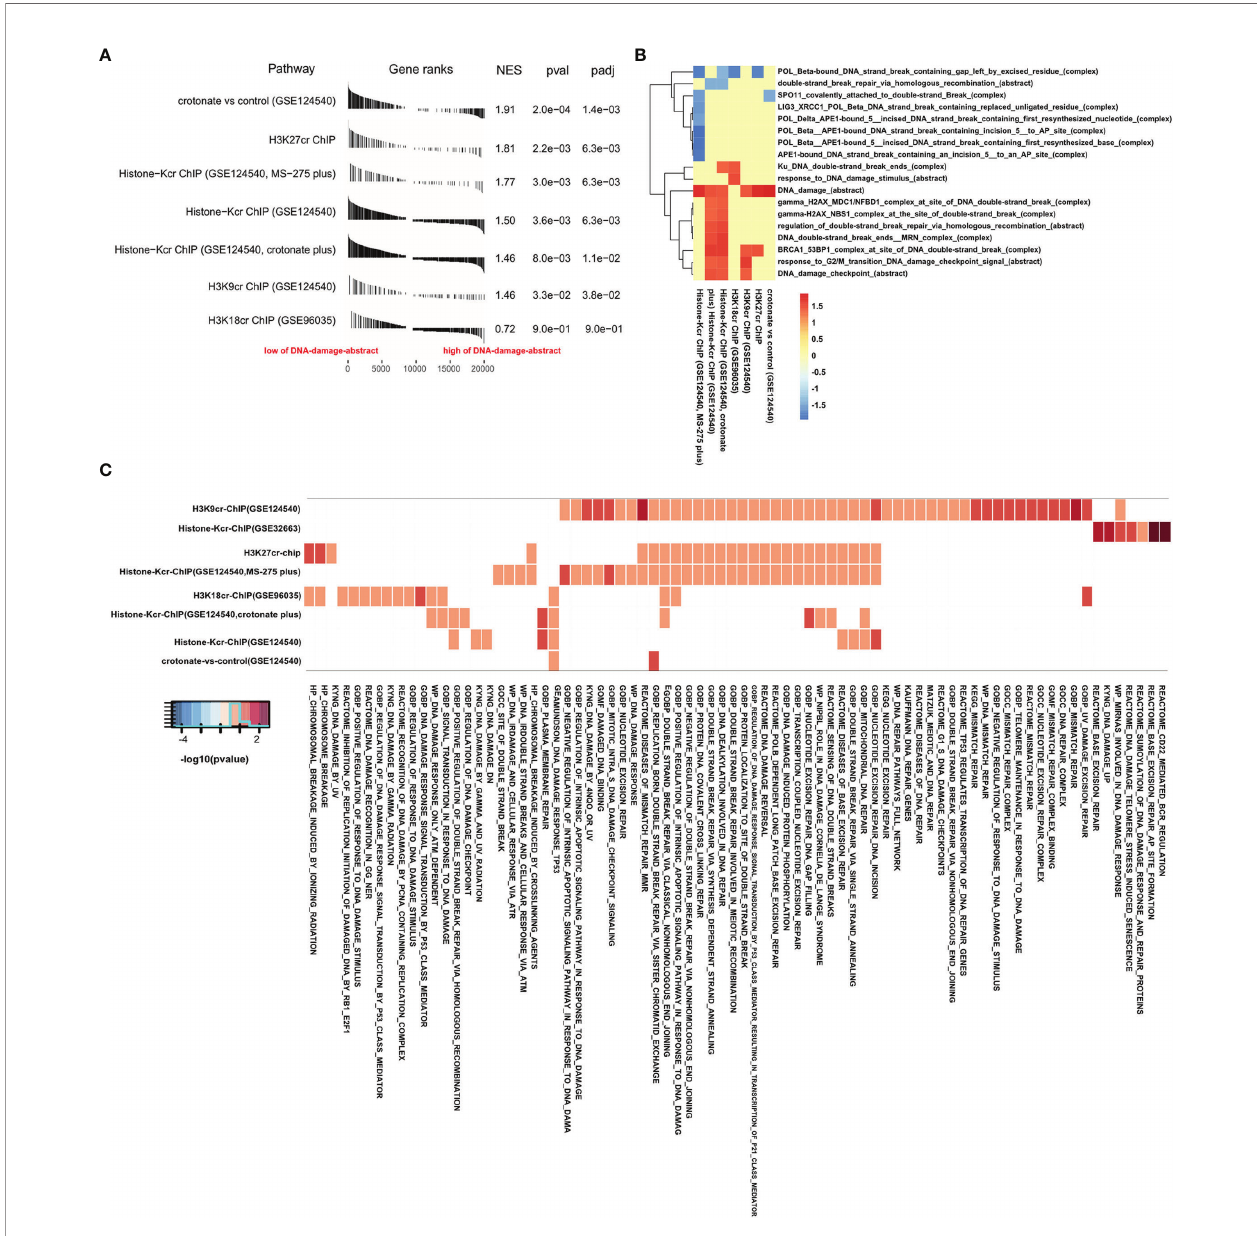
FIGURE 2 | Gene Set Enrichment Analysis (GSEA) con fi rmed that histone crotonylation is related to DNA damage in colon cancer. (A) GSEA showing DNA damage abstract value evaluated in the context of 7 gene sets representative for histone crotonylation in colon adenocarcinoma samples. (B) Heat map showing the enrichment of genes with promoter occupied by histone crotonylation in each DNA-damage-related complex or abstract process in GSEA. The normalized enrichment score is shown as color intensity. Blue indicates DNA-damage-related complex or abstract process negatively relevant to histone crotonylation, and red indicates the opposite. (C) Heat map showing the genes with promoter occupied by histone crotonylation involved in multiple DNA-damage-related pathways in Fisher ’ s exact test ( P < 0.05). The color intensity indicates the negative base 10 logarithm of the p -value. The white spaces meant that P >